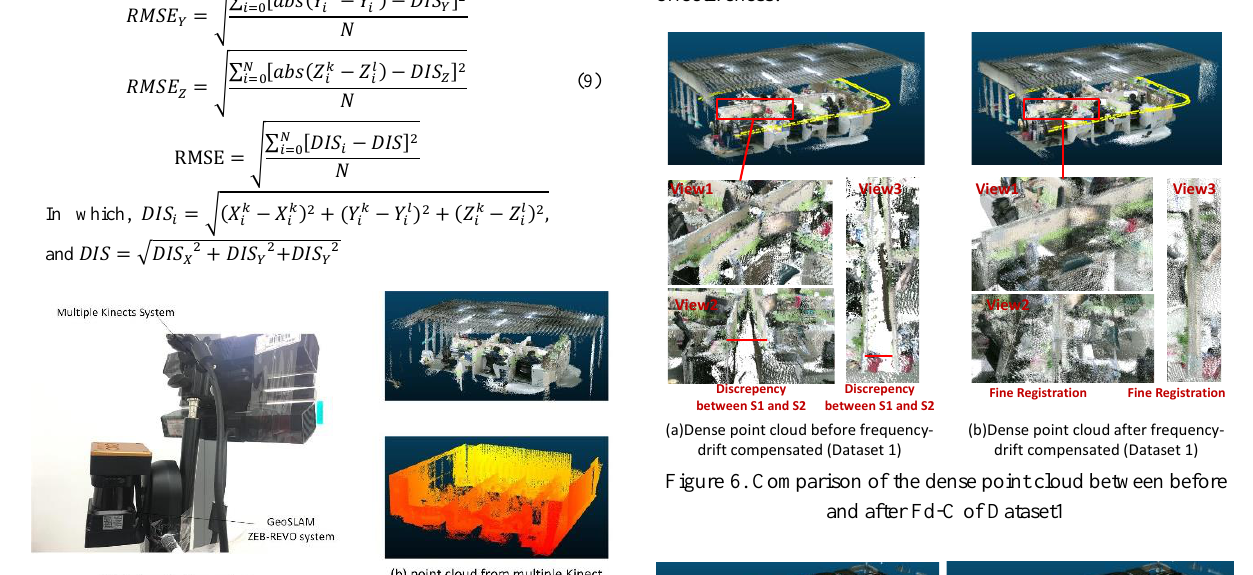
Figure 6 and Figure 7 show the point cloud build by the system without Fd-C and with Fd-C. In Figure 6(a), the point cloud are obtained by directly merging the point cloud from upward sensor and downward sensor with the calibrated EoPs. In Figure 6(b), the point clouds are obtained by the tracking results with the Fd- C solution. Significant discrepancy appeared in the point cloud before Fd-C, which can be found from components structure in different views. Rather than large discrepancy in point cloud, our proposed multiple RGB-D mapping method produces a better results. The inconsistency of tracking results between different sensor was eliminated and generated more accurate point cloud. As expected, in Figure 7, the mapping results in dataset 2 shows a similar results. The proposed multiple RGB-D mapping method achieve more accurate results and again verifying its